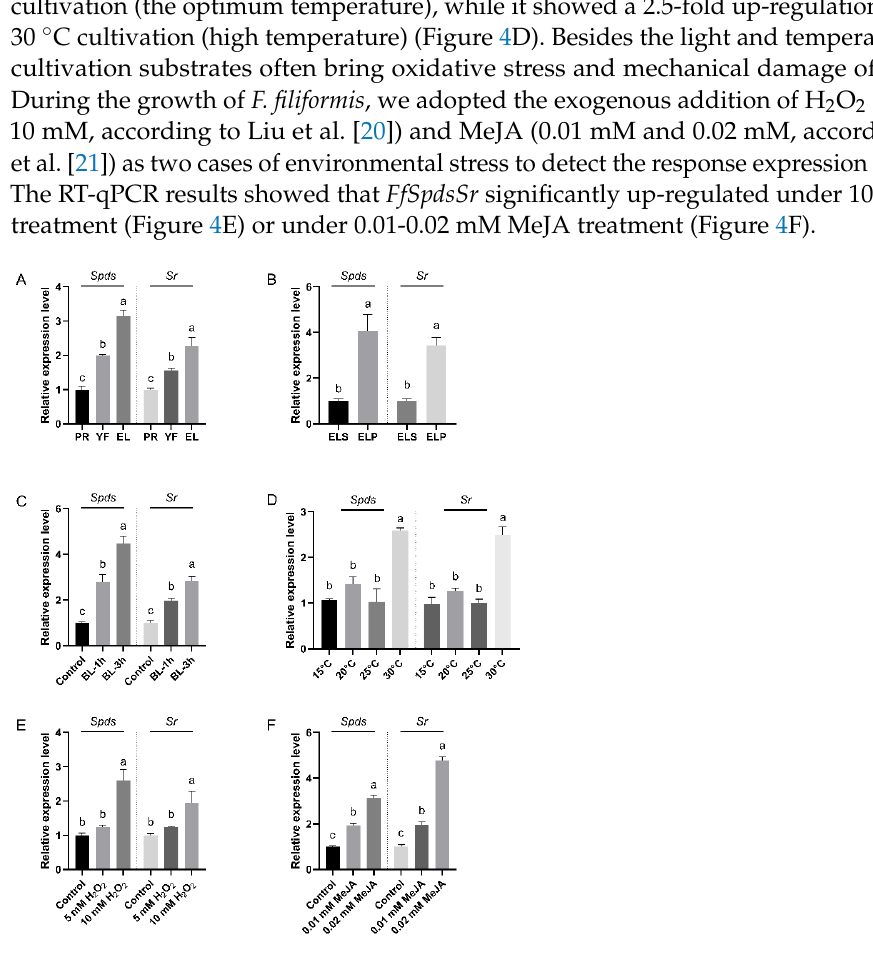
Figure 4. Relative expression levels of FfSpdsSr gene in different developmental stages, different tissues, and under different environmental factors in F. filiformis . ( A ) Relative expression levels of FfSpdsSr in different developmental stages of strain FL19. PR: primordia; YF: young fruiting body EL: elongation stage. ( B ) Relative expression levels of FfSpdsSr in different tissues of strain FL19. ELS: stipe in elongation stage; ELP: pileus in elongation stage. ( C ) Relative expression levels of FfSpdsSr under blue light conditions. BL-1h: 1 h under blue light irradiation, BL-3h: 3 h under blue light irradiation. ( D ) Relative expression levels of the FfSpdsSr gene of F. filiformis in strain FL19 under different temperature gradients, including 15 ◦ C (cold stress), 20 ◦ C (low-temperature stress), 25 ◦ C (the optimum temperature, as control), and 30 ◦ C (high-temperature stress). ( E ) Relative expression levels of FfSpdsSr gene of F. filiformis in strain FL19 under H 2 O 2 condition. ( F ) Relative expression levels of FfSpdsSr gene of F. filiformis in strain FL19 under MeJA condition. ( A – F ) Spds represents the RT-qPCR results using the primers FfSpdsF/R designed in the SPDS domain, and Sr represents the RT-qPCR results using the primer FfSrF/R designed in the SR domain. All values are the means ± SD of three independent experiments, and the lowercase letters indicate significant differences among different samples ( p <